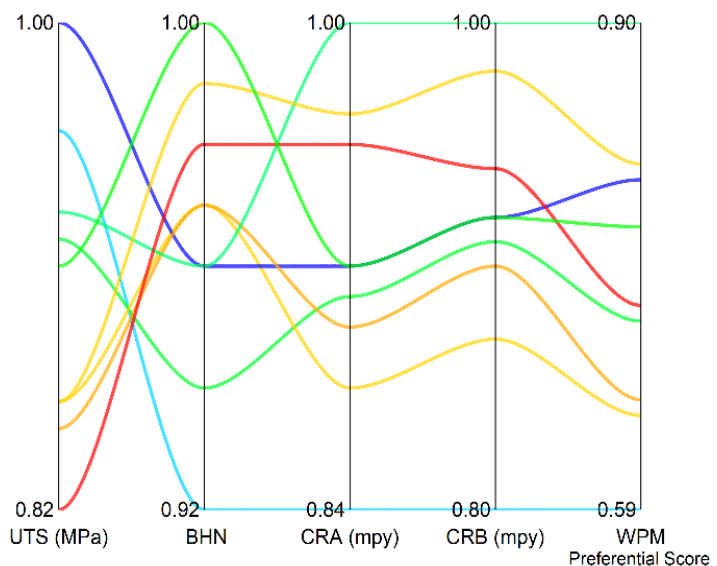
Figure 4. Parallel plot denoting the weighted vectors and weighted product model (WPM) preferential score.